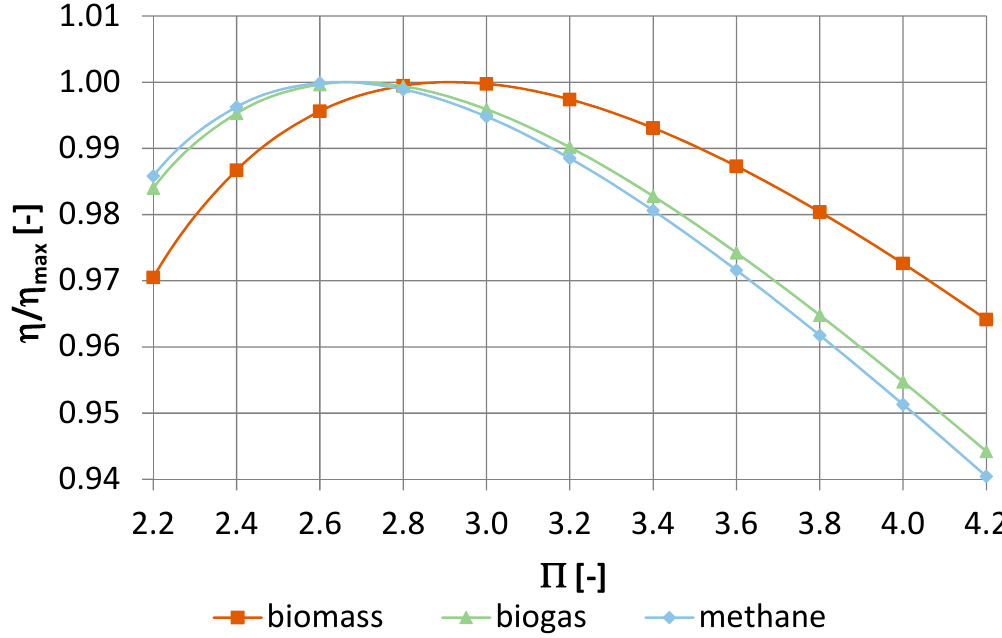
Figure 4. Effect of compression ratio ∏ on the value of relative efficiency (referred to the maximum value) for three exemplary fuels in variant 2.